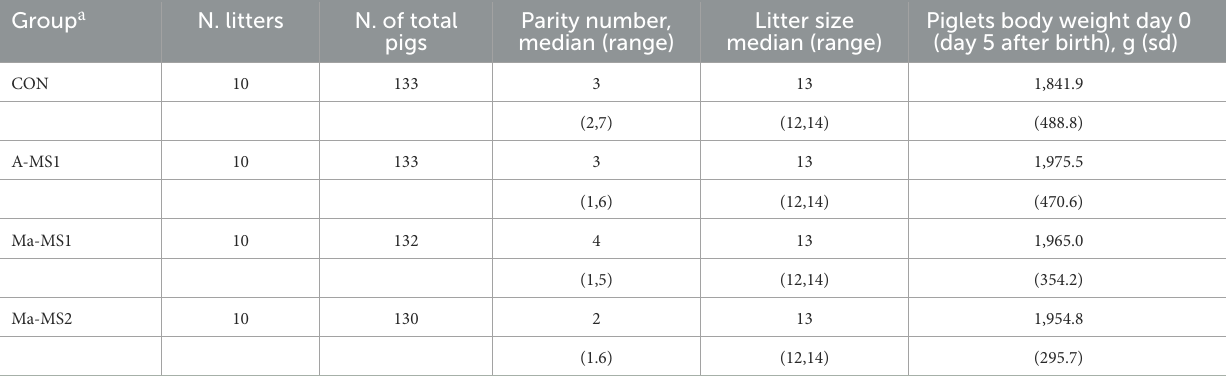
TABLE 1 Experimental design.